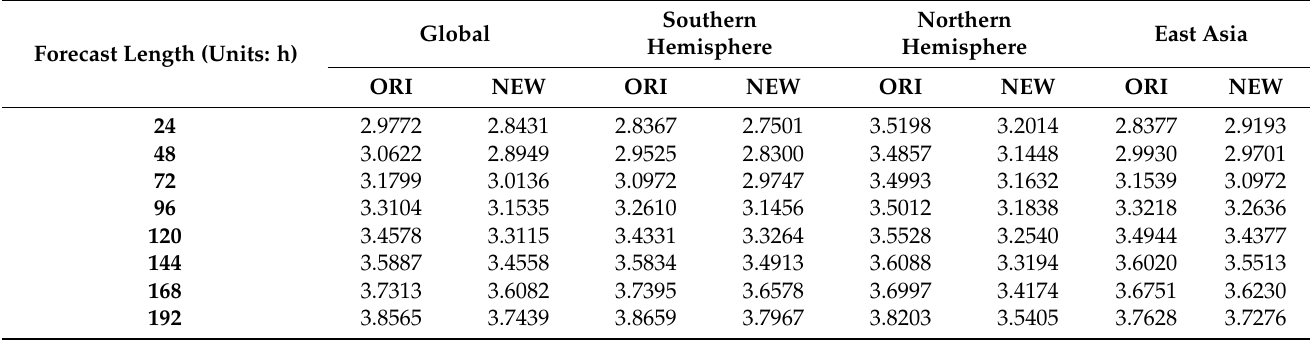
Table 12. RMSE of 24 h net evapotranspiration between GRAPES forecast and GLDAS in different regions (units: